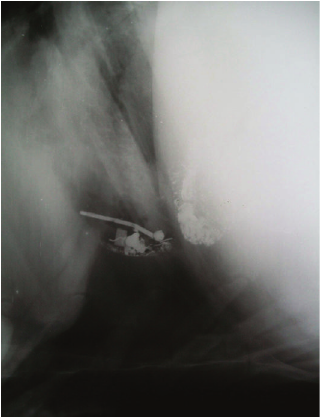
Figure 1: Lateral radiograph of reticulum showing clearly demarca- ble diaphragmatic line and presence of potential and nonpotential metallic densities cranial to diaphragm.